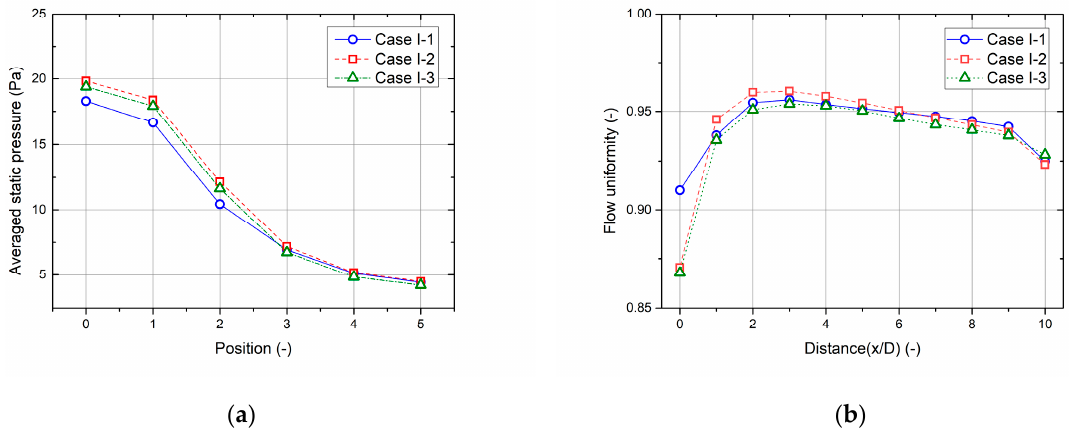
Figure 5. Simulation results: ( a ) Static pressure distribution; ( b ) flow uniformity distribution.